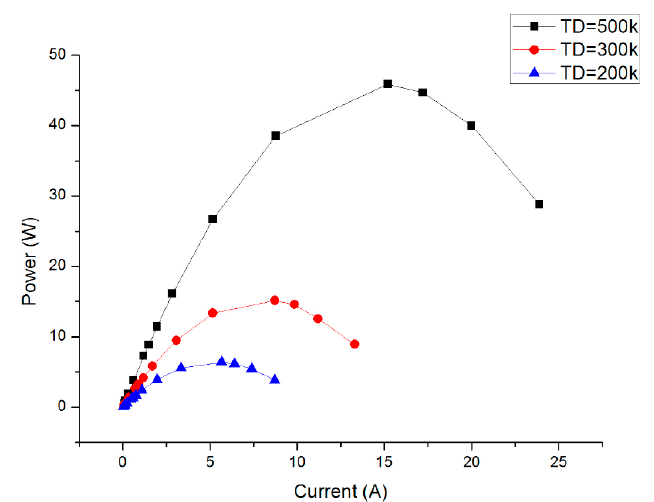
Figure 12. Output power versus current.